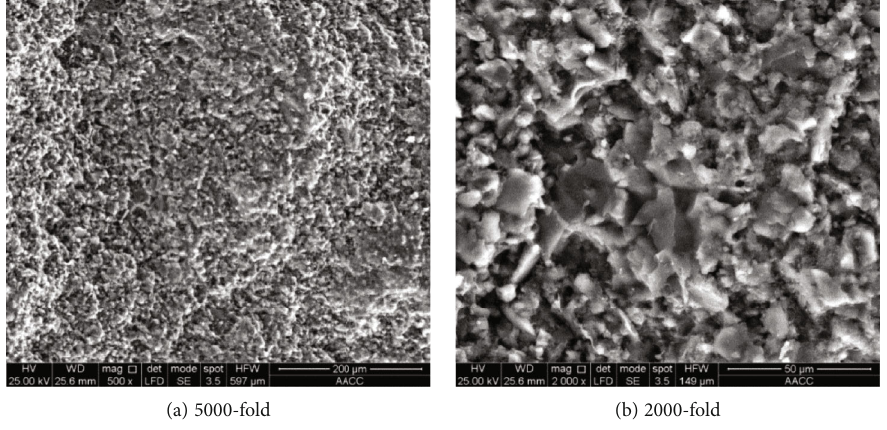
Figure 4: SEM images of silty